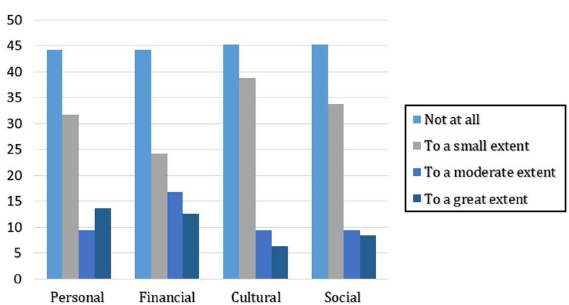
Fig. 5. Negative impact of bush encroachment on a personal, financial, cultural and social level (Source: own elaboration)